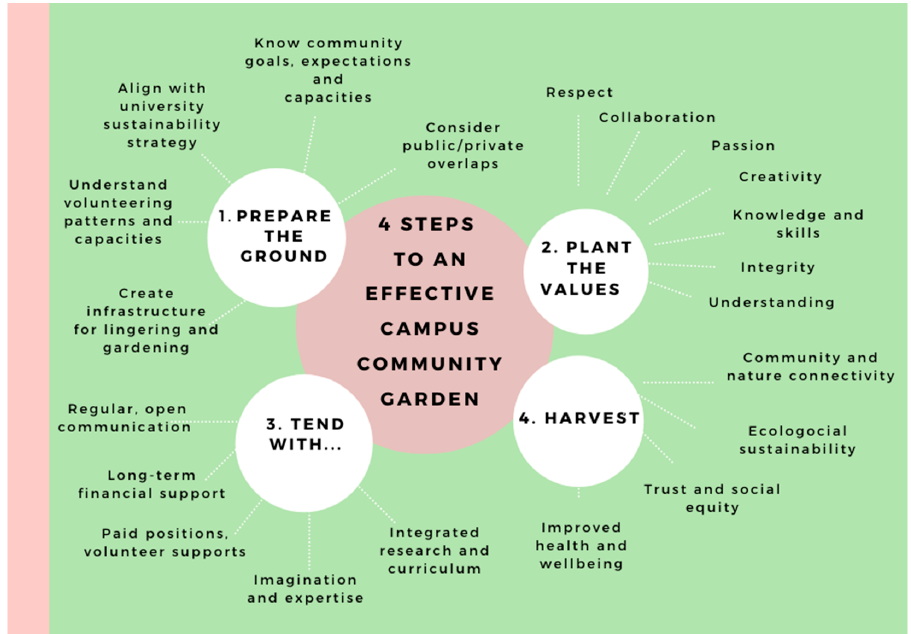
Figure 10. Four steps to an effective campus community garden.